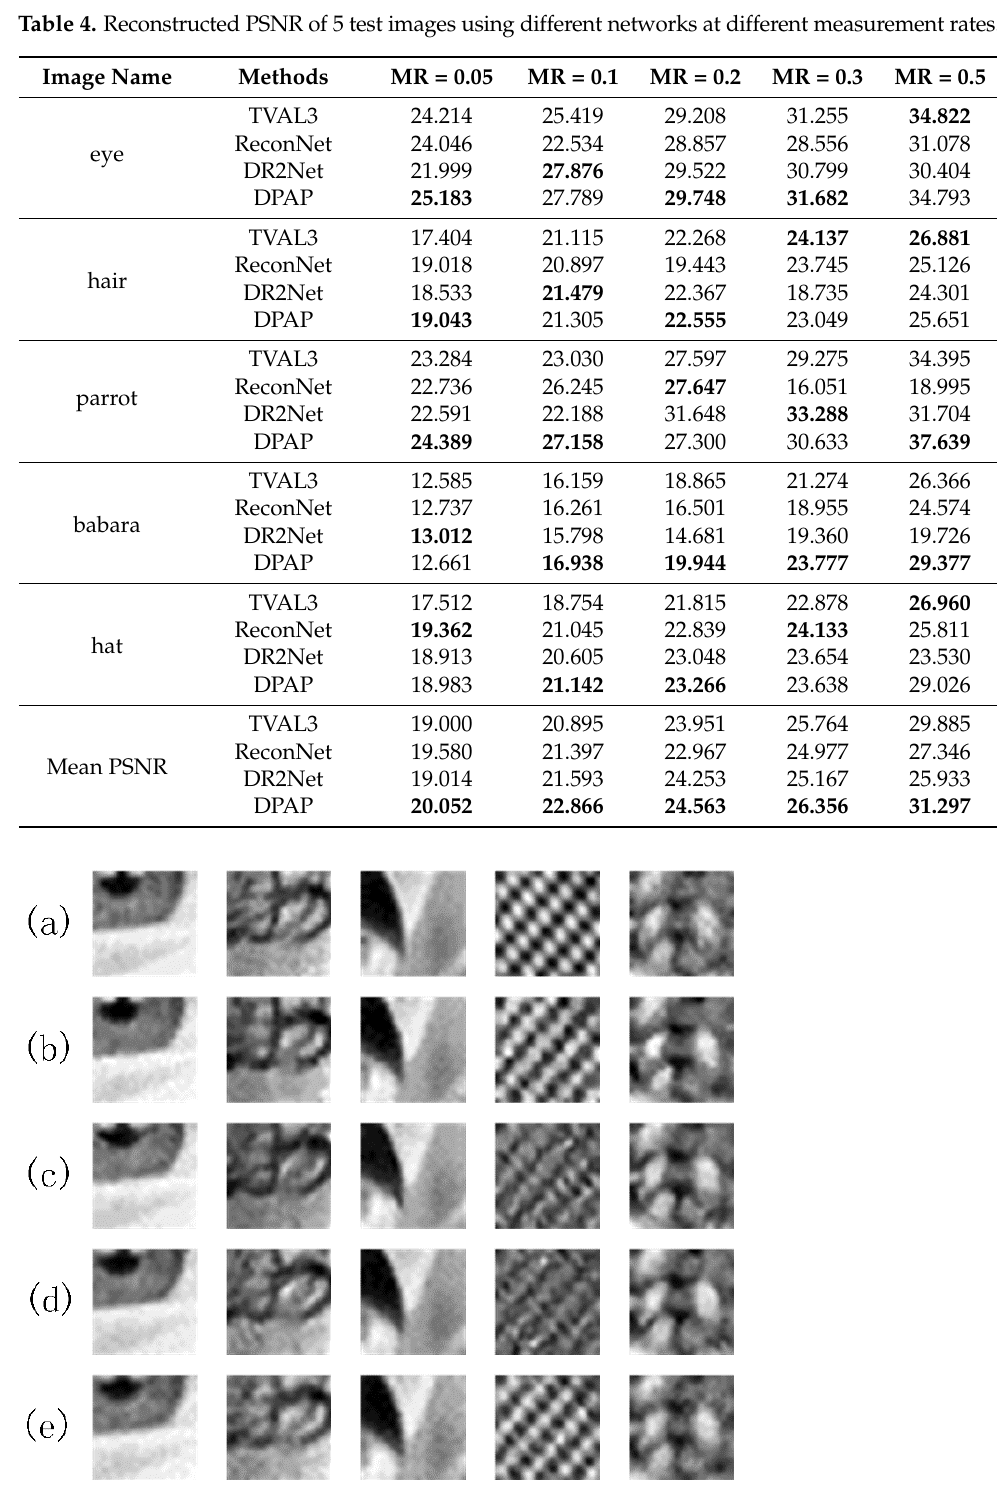
Figure 14. Reconstructed images of 5 test images under different algorithms at a measurement rate of 0.2, from top to bottom are ( a ) original images; ( b ) reconstructed by TVAL3; ( c ) reconstructed by ReconNet; ( d ) reconstructed by DR2Net; ( e ) reconstructed by DPAP.